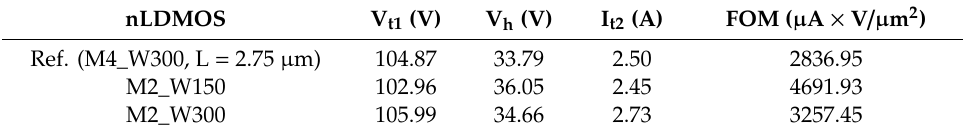
Table 3. Snapback extracted parameters of HV nLDMOSs with channel-width modulation.